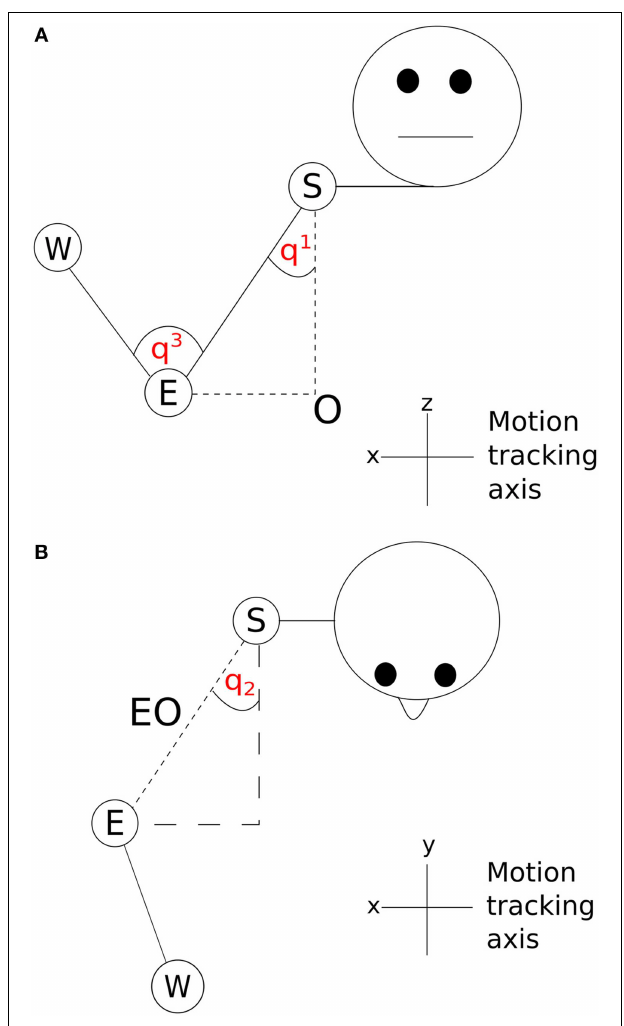
FIGURE 5 | Visualization of joint angles (A) q 1 and q 3 and (B) q 2 ; S, shoulder; E, elbow; W, wrist; O, origin.